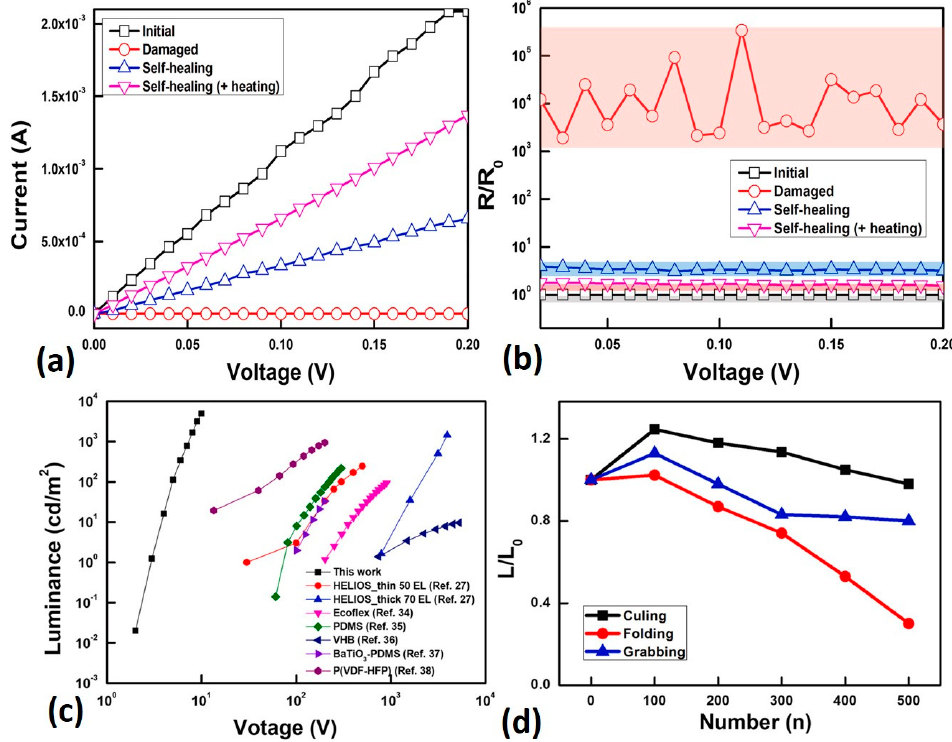
Figure 3. Electrical and luminescence properties of self-healable organic light-emitting devices. ( a ) Voltage vs. current diagram in which self-healing helps obtain better resistance against deformation. ( b ) Voltage vs. resistance curve showing the recovery of the crack after deformation. ( c ) Voltage vs. luminescence curve that shows the comparison of various types of materials with self-healing characteristics, indicating better luminescence behavior. ( d ) Luminescence ratios at various physicomechanical actions. Re-printed with permission; License Number: 5484060034281 [52]. Copy-